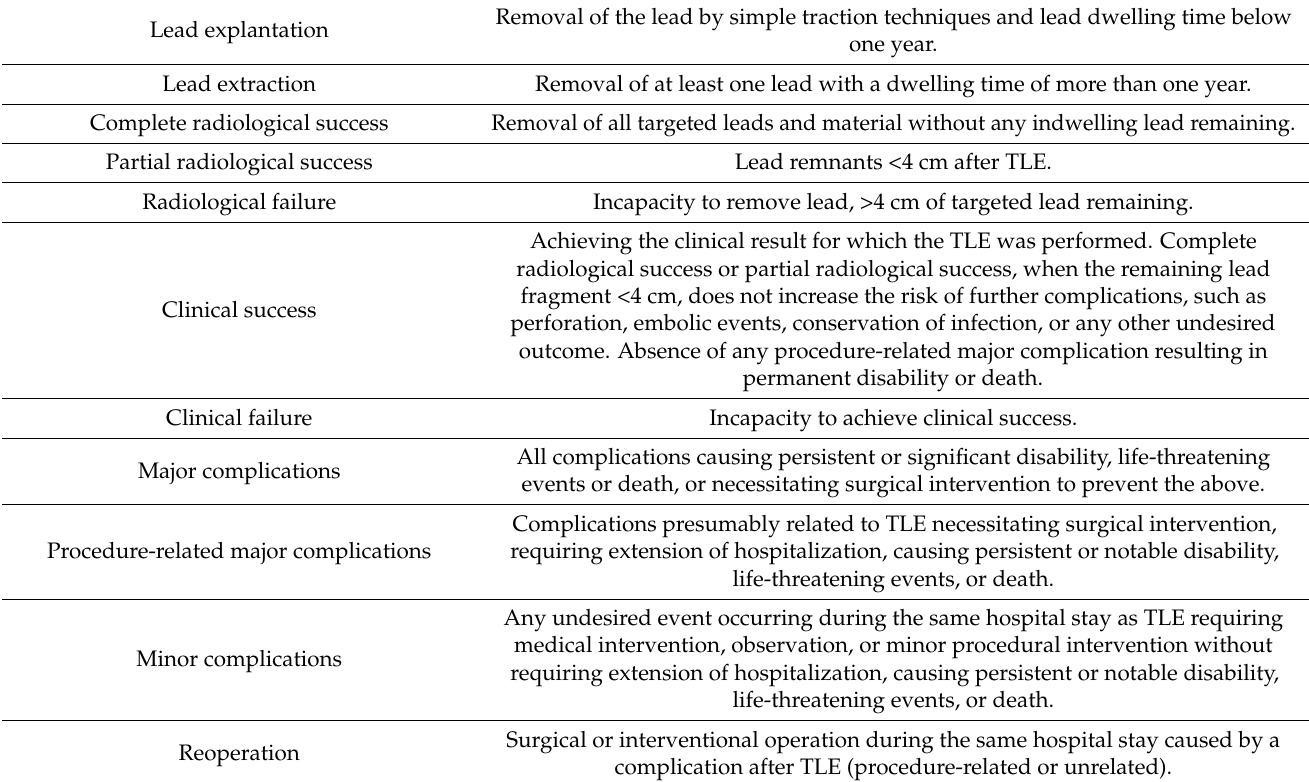
Table 1. Definitions. TLE: transvenous lead extraction.